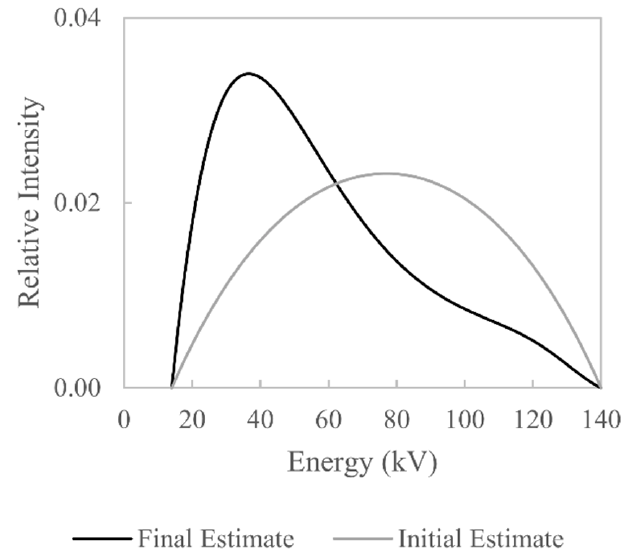
Figure 11. Comparison between initial and final estimated X-ray spectra based on measured attenuation values.